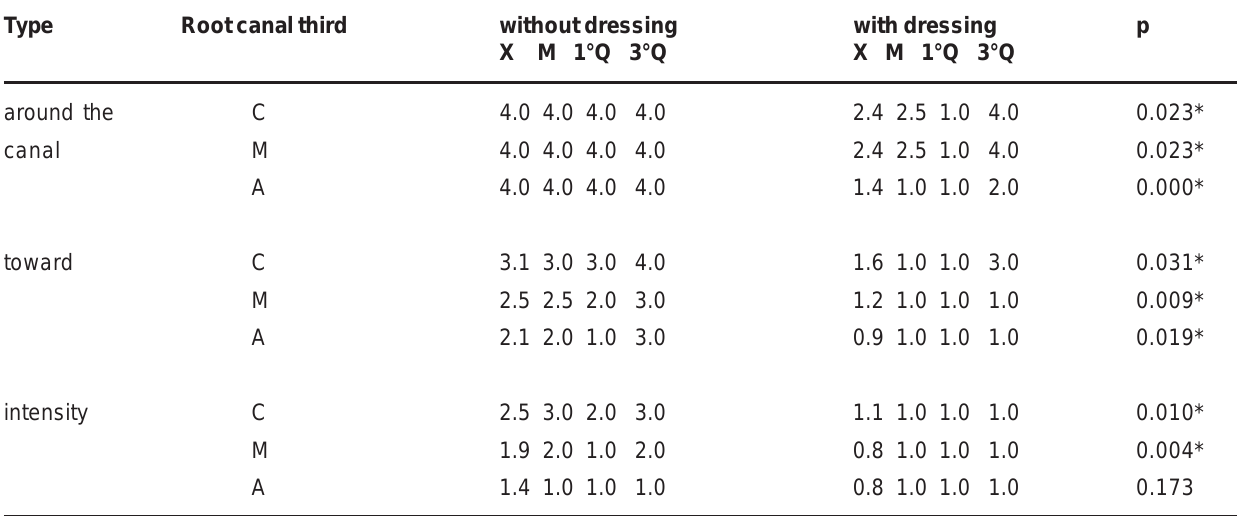
TABLE 2- Values for mean (X), median (M), 1 st quarter (1 st Q), 3 rd quarter (3 rd Q) and probability (p) for the scores given in the groups of methyl blue in the conditions with and without Type